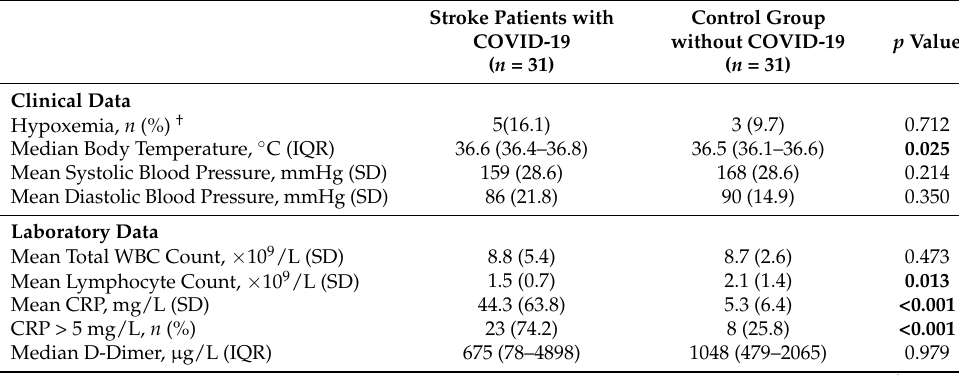
Table 2. Baseline clinical and laboratory